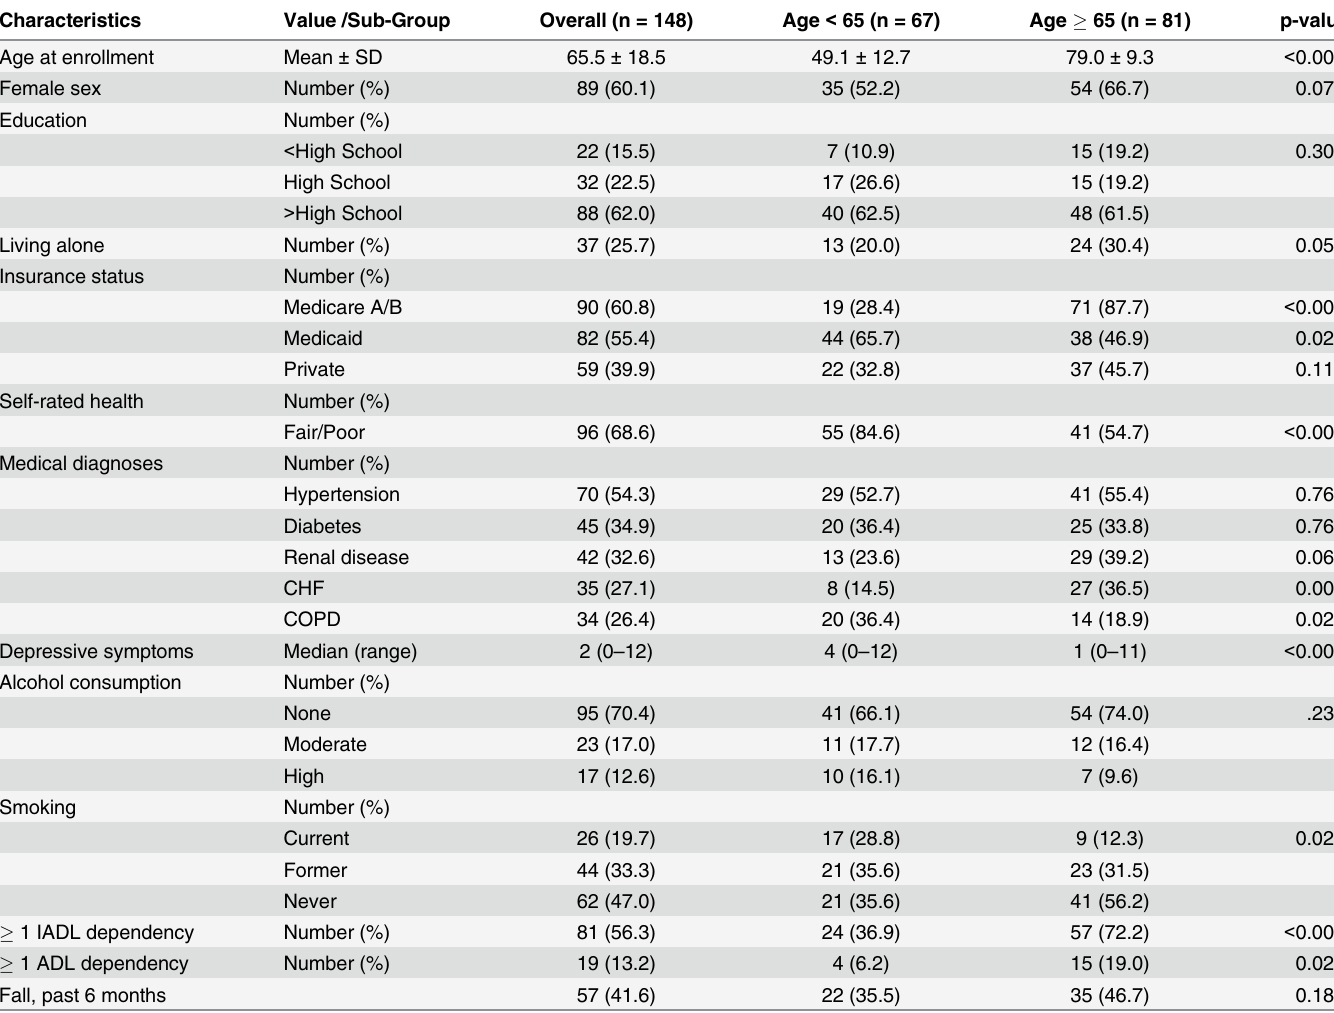
Table 1. Characteristics of Care Support